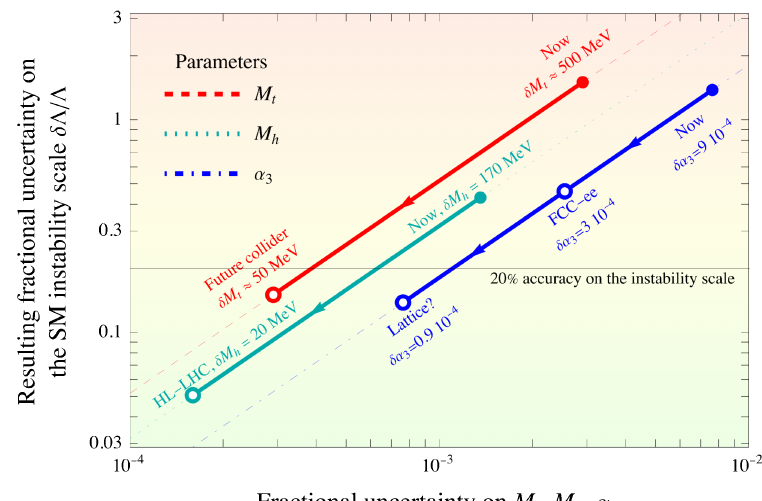
Figure 2 . The 1 σ relative uncertainty on the scale of instability determined by eq. (2.3) as function of the relative precision of the measurements of α corresponds to a determination of the instability scale at 20% precision. The current situation and future improvements are marked as full and empty dots,